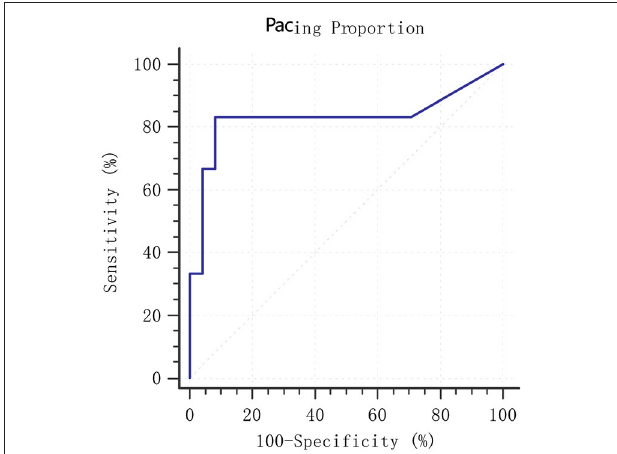
FIGURE 4 | ROC analysis of pacing proportion for prediction of MACE. MACE: composite endpoint of readmission for HF and cardiac mortality; ROC, receiver operating characteristic; MACE, major adverse cardiovascular events. HF, heart failure. disease, percutaneous coronary intervention (PCI) history, smoking, hemoglobin, albumin, creatinine, NT-proBNP, native QRSd, LVEF, HBP were comparable between HPP group and LPP group (all p > 0.05). The dosages of β -blockers in HPP group were significantly lower than those in LPP group ( p = 0.018).